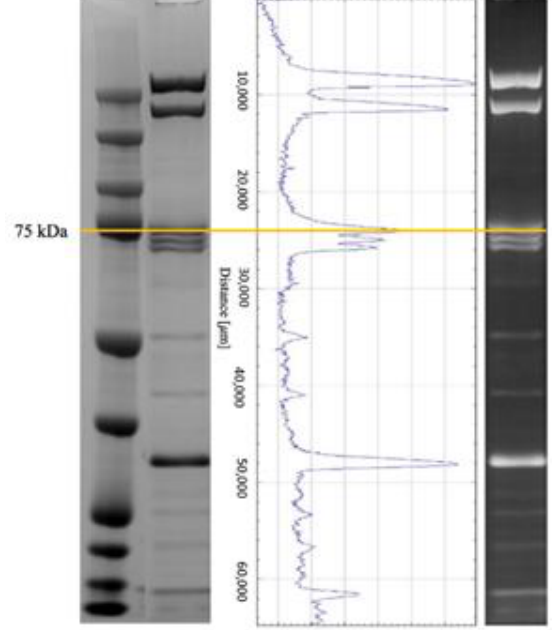
Figure 3. From left to right: molecular weight marker; representative lane of a gel; pherogram of the same lane as acquired through Fiji software; lane with inverted colours as needed for image analysis. The line highlights the zone of the gel, comprising a range of 22,064–24,015 µ m, including the band cut for mass